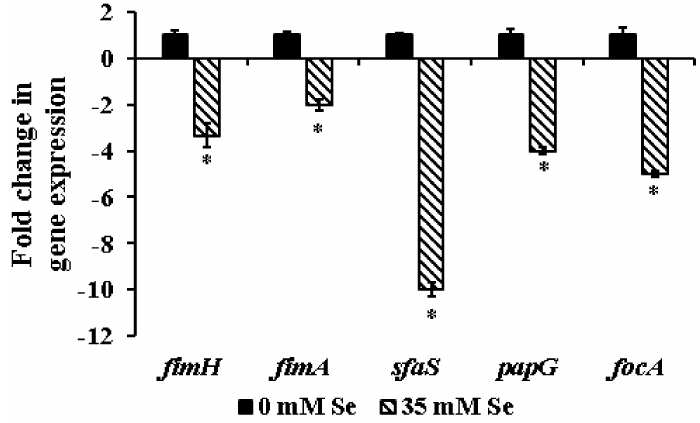
Figure 3. Effect of sub-inhibitory concentrations of selenium on the expression of biofilm genes in UPEC. Relative gene expression was assayed using the StepOne Plus Real Time PCR System. The data were normalized to the endogenous control and the level of candidate gene expression between selenium-treated and untreated samples was compared to study relative gene expression. * Treatments are significantly different from the control at p ≤